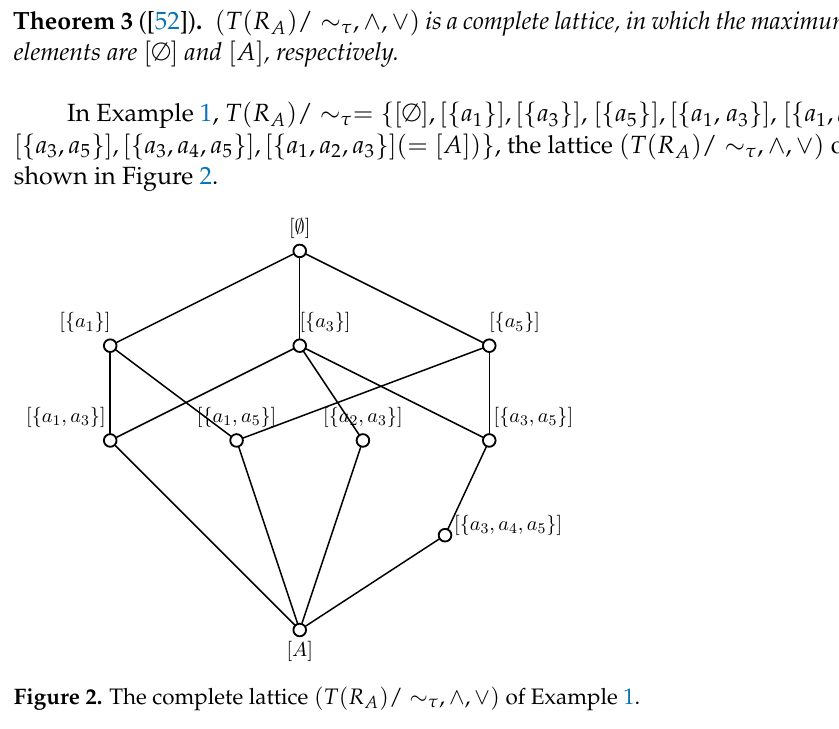
Figure 2. The complete lattice ( T ( R A ) /